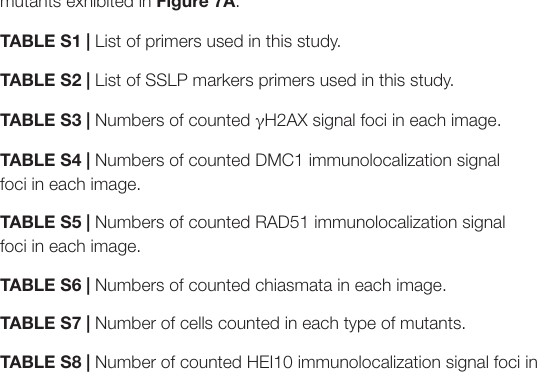
FIGURE S4 | γ H2AX localization in leptotene and pachytene meiocytes of wild type and atm mutants. (A) Immunolocalization of γ H2AX in leptotene meiocytes of wild type and atm mutants. (B) Dual-immunolocalization of γ H2AX (red) and ZYP1 (green) in pachytene meiocytes of wild type and atm mutants. Chromosomes FIGURE S8 | Examples of metaphase I chromosome morphology for Figure 7A .